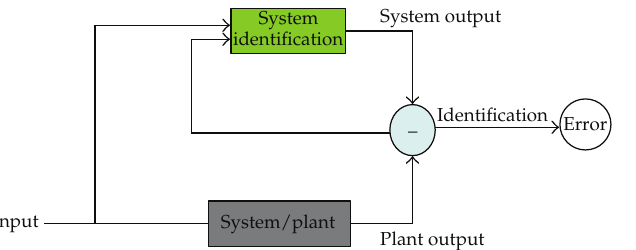
Figure 1: Block diagram of system